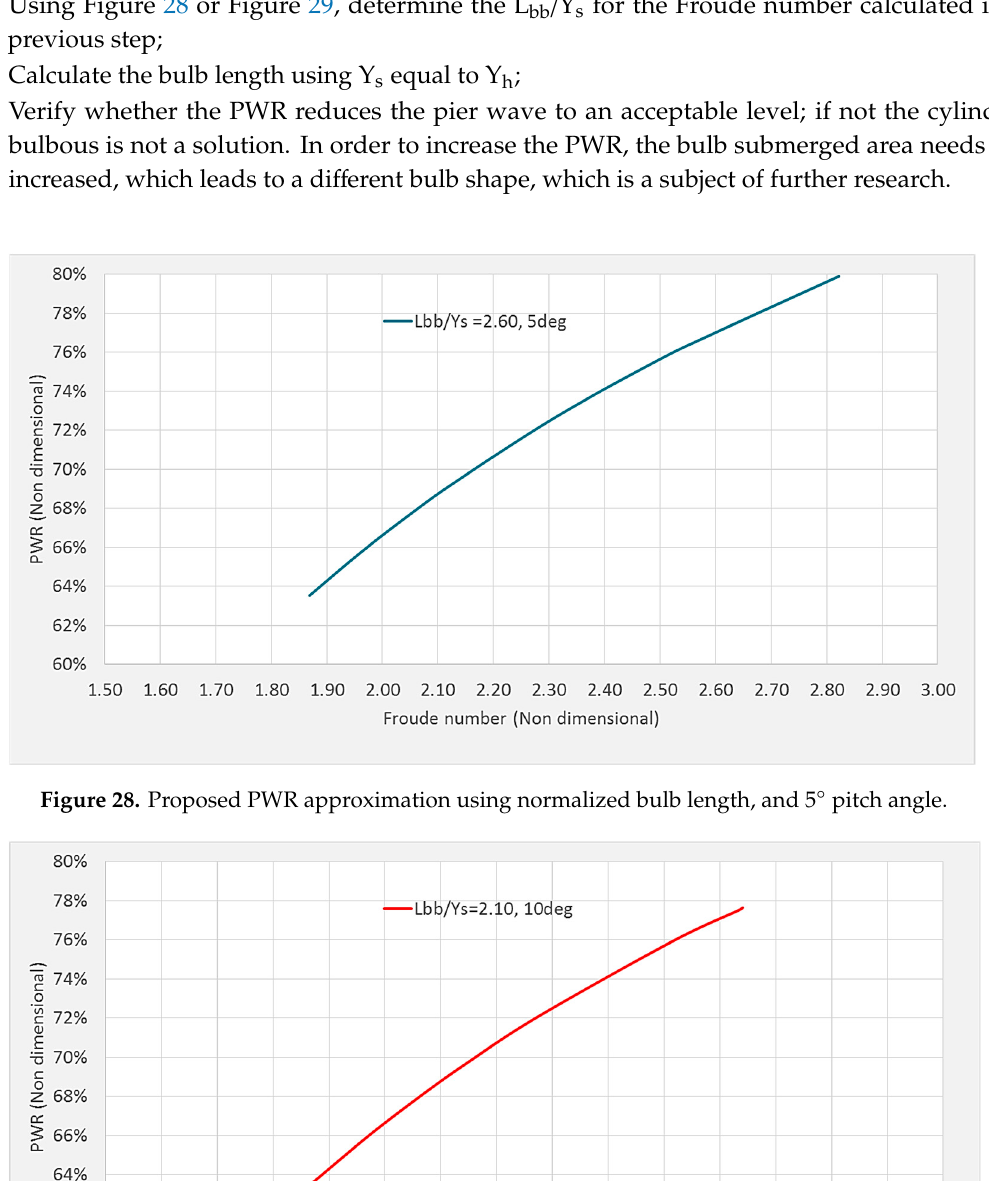
Figure 28. Definition of the bulb submerged depth and bulbous length.